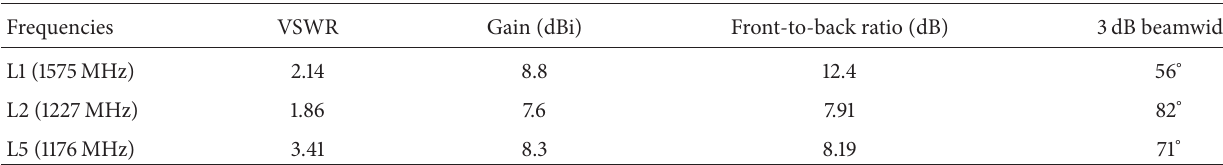
Table 4: Properties of the proposed modified PIFA.